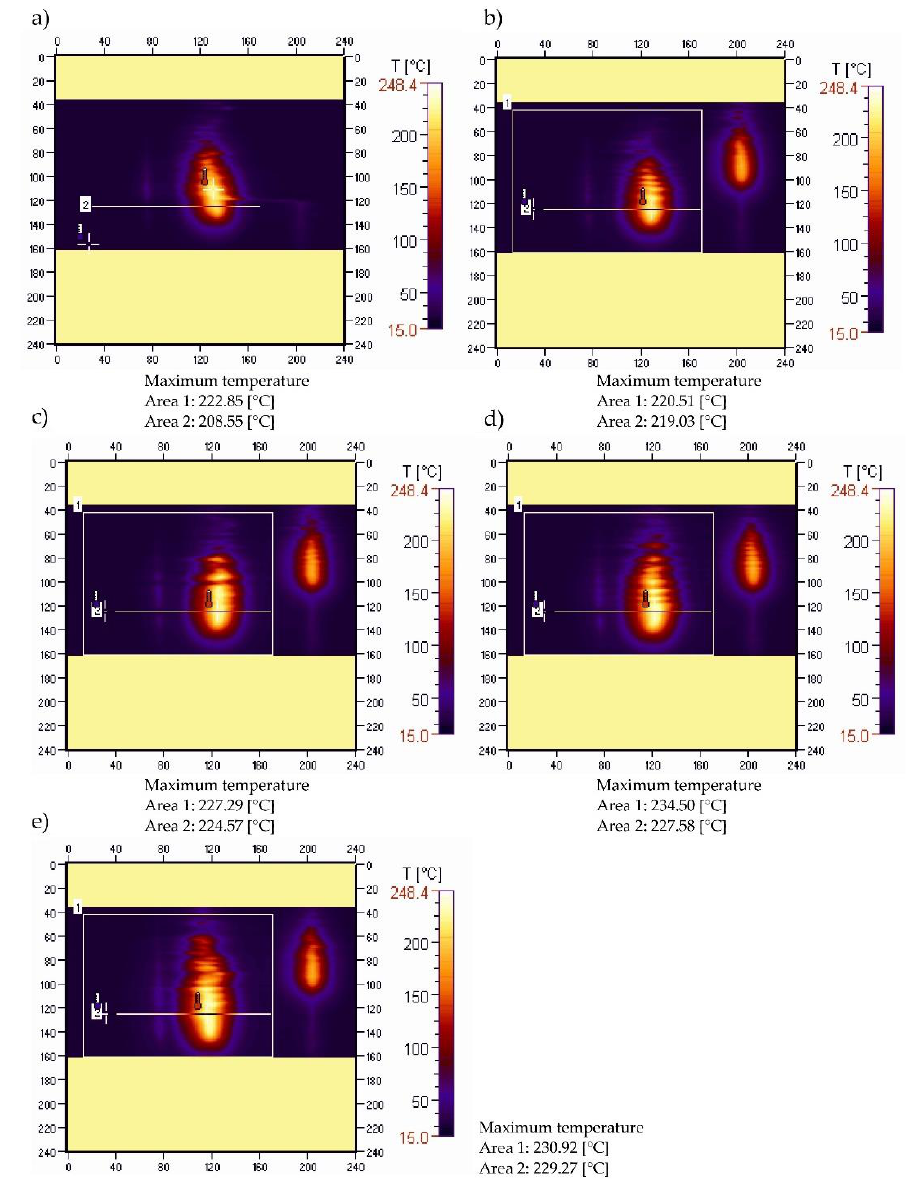
Figure 7. Thermograms of PBS50 sample recorded during ignition ( a ), and after: ( b )—15, ( c )—30, ( d )—45, ( e )—60 s after the ignition source was removed.